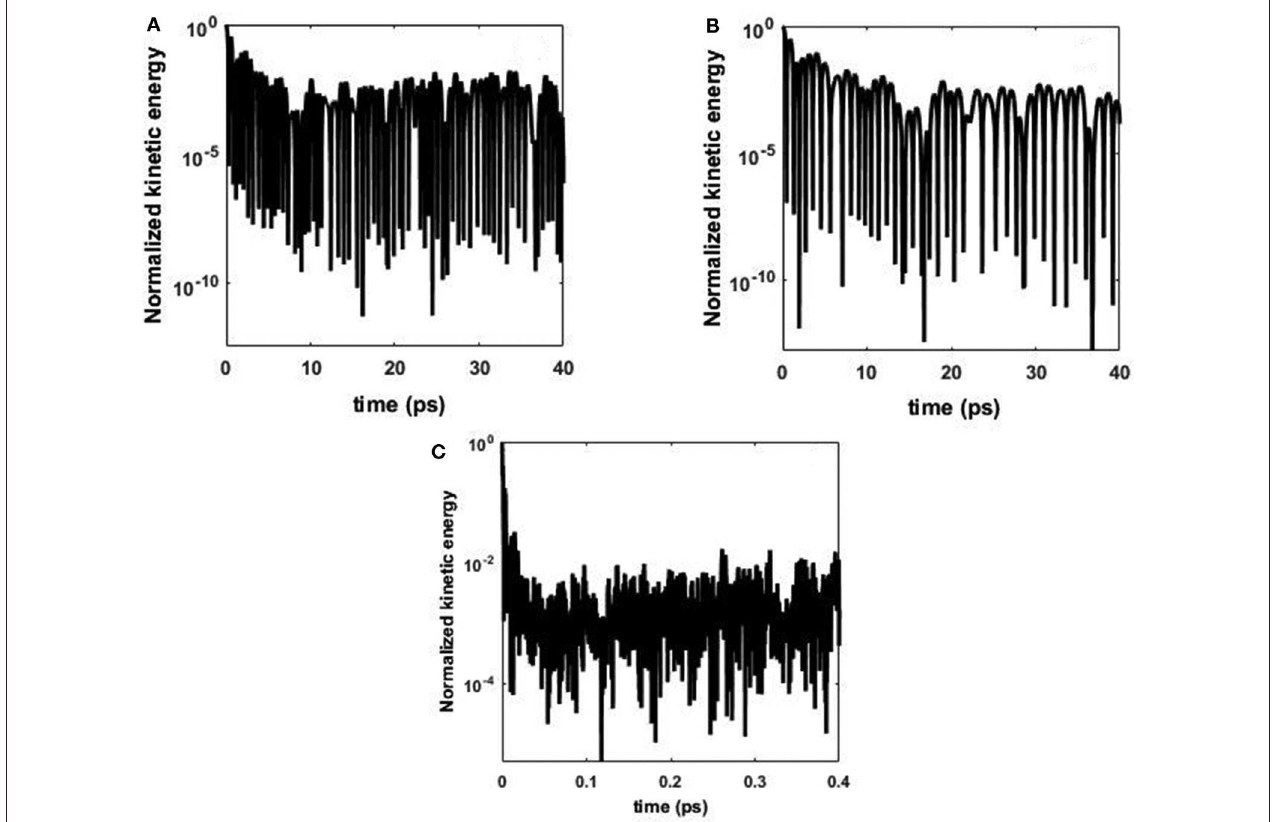
FIGURE 3 | Kinetic energy atom 544 in graphene. (A) Harmonic potential, (B) anharmonic potential, and (C) Tersoff potential.